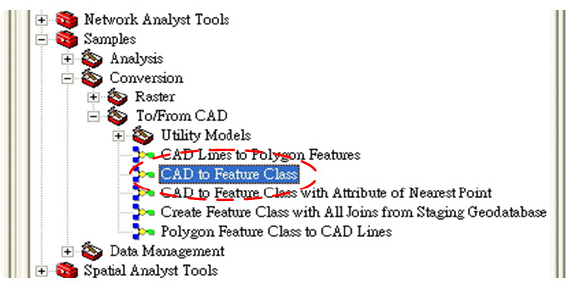
Fig. 9. Tool for map-layer transformations